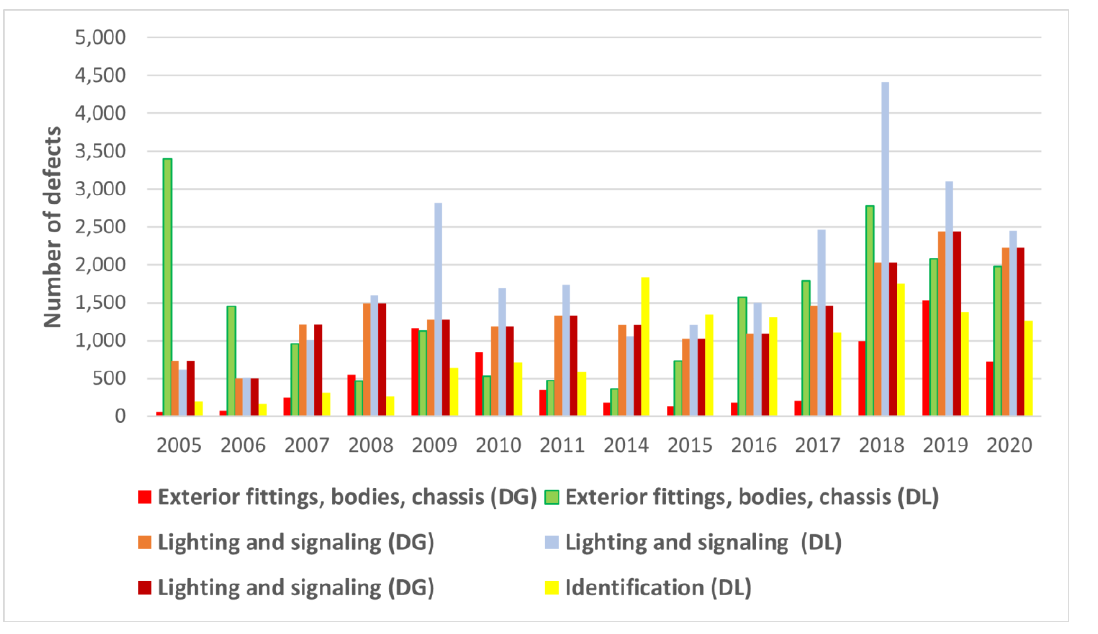
Figure 3. Number of serious (DG) and minor (DL) defects in lighting and signaling, identification and exterior fitting, bodywork, and chassis per year.